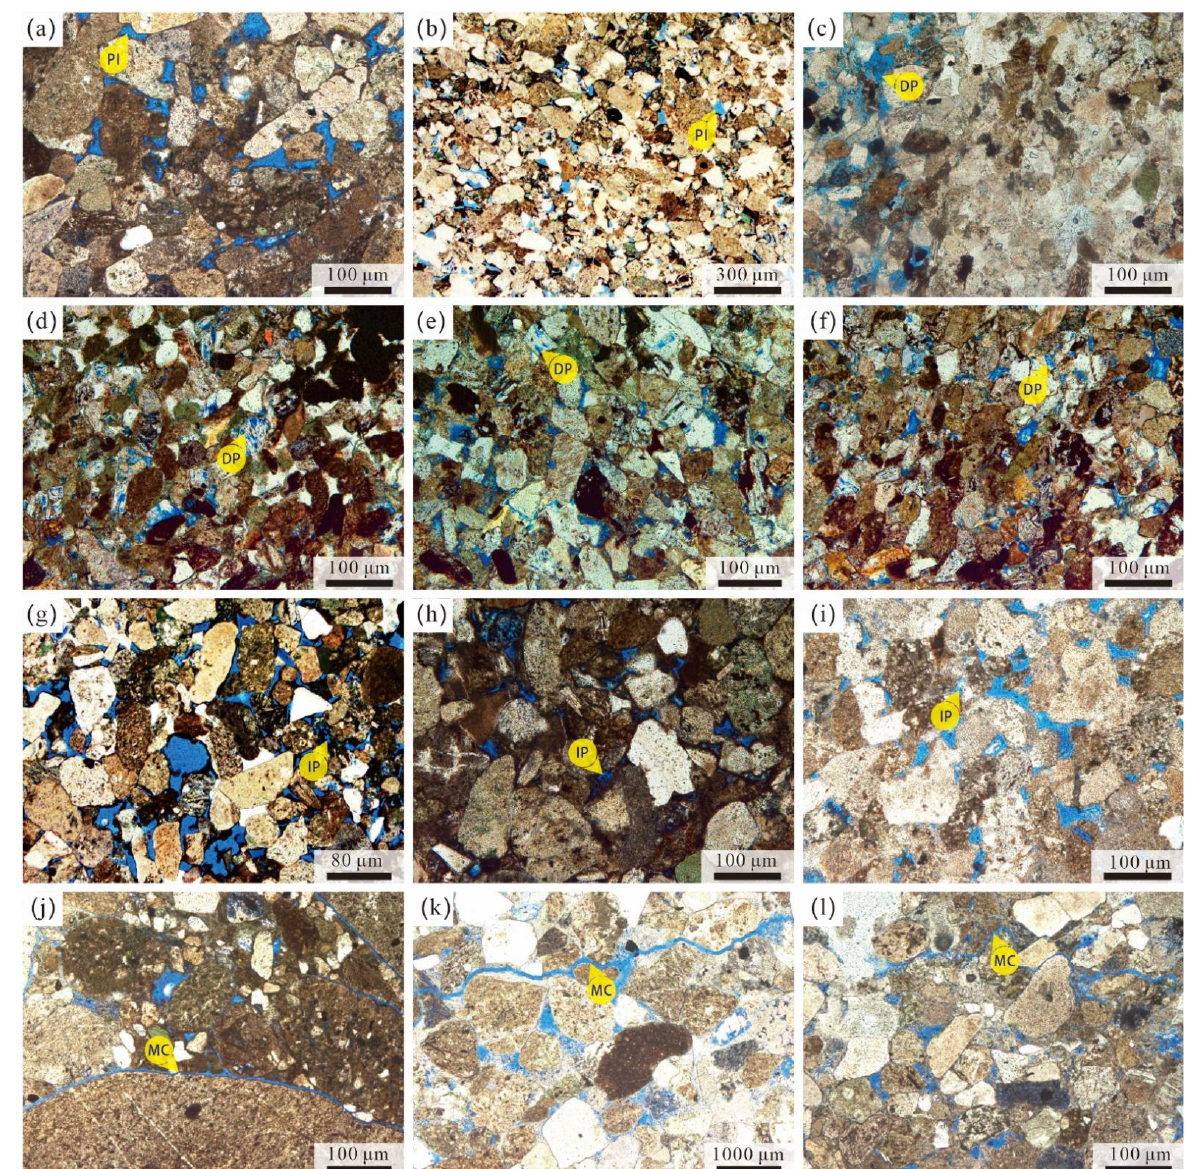
Figure 6. Reservoir microscopic characteristics of the Jiucaiyuan Formation in the Beisantai Uplift. ( a ) Poorly-sorted pebbly sandstone with primary intergranular pores and angular to subangular particles; Drillcore SZ-2, 3417.63 m, Member II; PPL. ( b ) Well-sorted medium-grained sandstone with primary intergranular pores; Drillcore HB-8, 2139.24 m, Member I; PPL. ( c ) Well-sorted me- dium-grained sandstone with secondary dissolution pores and subangular particles; Drillcore AW- 5, 2695.05 m, Member I; PPL. ( d ) Fine-grained sandstone with medium sorting, secondary dissolu- tion pores, and subangular particles; Drillcore FL-5, 2646.6 m, Member I; PPL. ( e ) Fine-grained sand- stone with medium sorting, secondary dissolution pores, and subangular particles; Drillcore FL-5, 2646.79 m, Member I; PPL. ( f ) Well-sorted fine-grained sandstone with secondary dissolution pores and subangular particles; Drillcore FL-5, 2647.49 m, Member I; PPL. ( g ) Well-sorted medium- grained sandstone with intergranular pores and subrounded particles; Drillcore HB-8, 2138.84 m, Member I; PPL. ( h ) Fine-grained sandstone with medium sorting, intergranular pores, and suban- gular particles; Drillcore SZ-2, 3415.70 m, Member II; PPL. ( i ) Coarse sandstone with medium sort- ing, intergranular pores, and subrounded particles; Drillcore SZ-2, 3417.93 m, Member II; PPL. ( j )